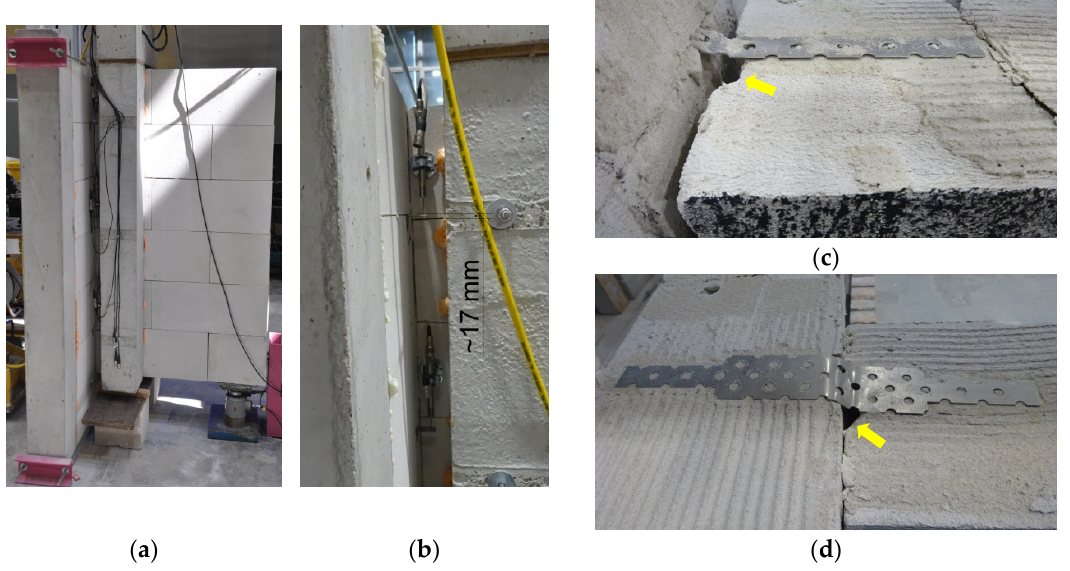
Figure 7. Failure of reinforced models: ( a ) damaged model (B10_1), ( b ) damaged model with dimensioned displacement between bed joints (B10_2), ( c ) typical bending of punched flat profile near the contact surface (B10_1), ( d ) typical bending of punched flat profile near the contact surface (BP10_3).